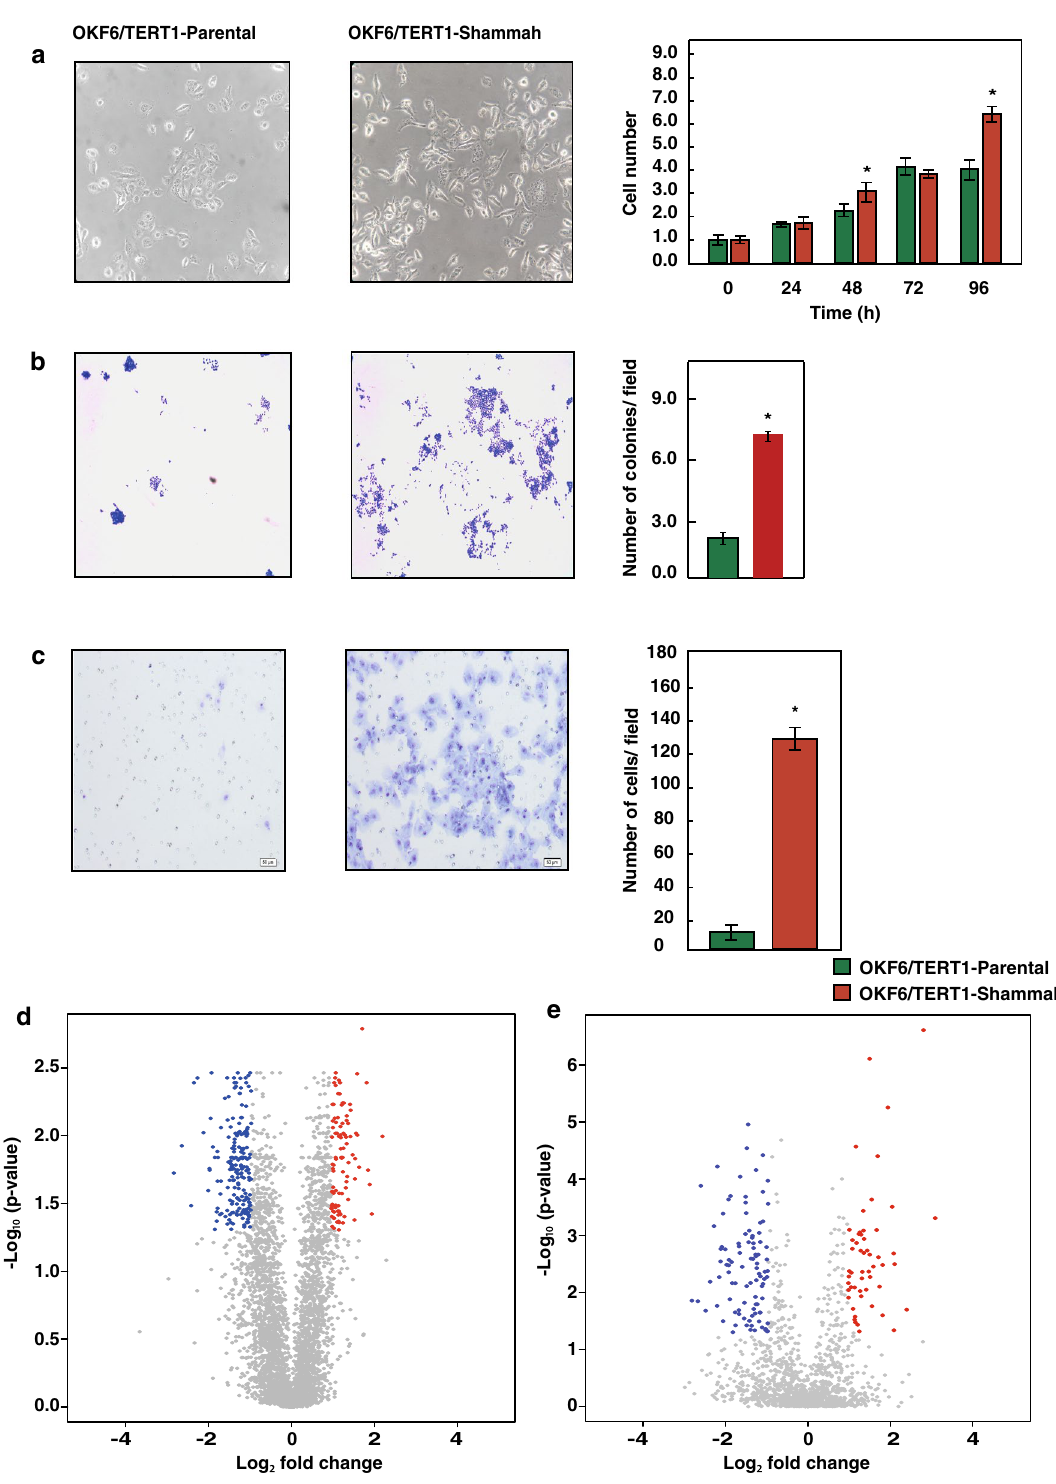
Figure 1. Chronic shammah treatment induces phenotypic alterations in oral keratinocytes. OKF6/TERT1- Parental and OKF6/TERT1-Shammah cells were assessed for ( a ) cellular proliferation ( b ) colony formation and ( c ) invasive capability with corresponding bar graphs shown in the right panel. Volcano plot representation of OKF6/TERT1 cells treated with shammah extract ( d ) total proteomics ( e ) phosphoproteomics. Significantly (p ≤ 0.05) overexpressed and downregulated proteins are depicted in red and blue,